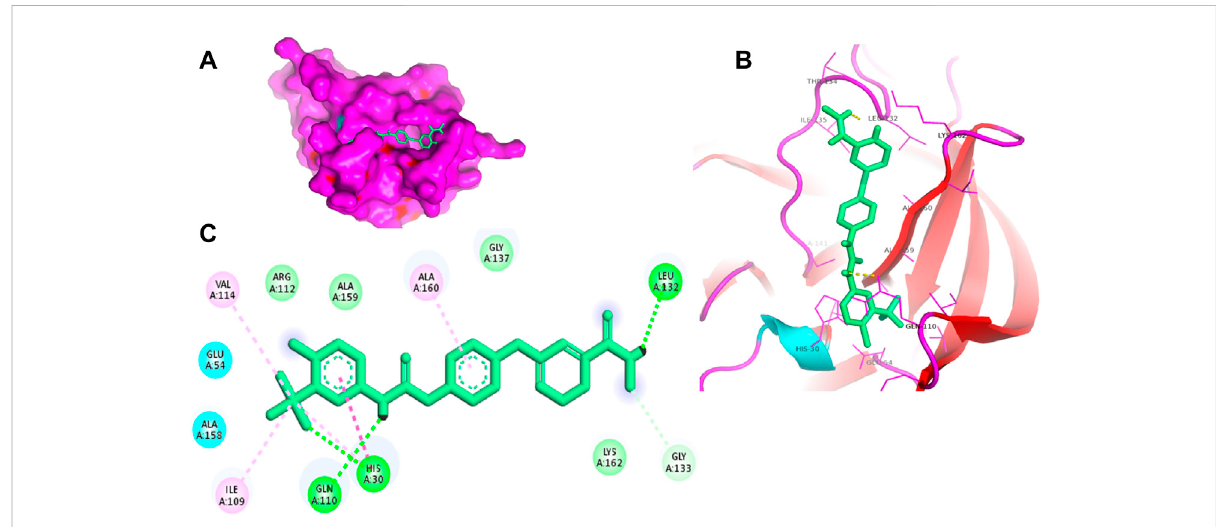
FIGURE 2 Surface view of sorafenib in the 3CLP binding pocket (A) , 3D (B) and 2D (C) interacting residues of 3CLP with sorafenib.